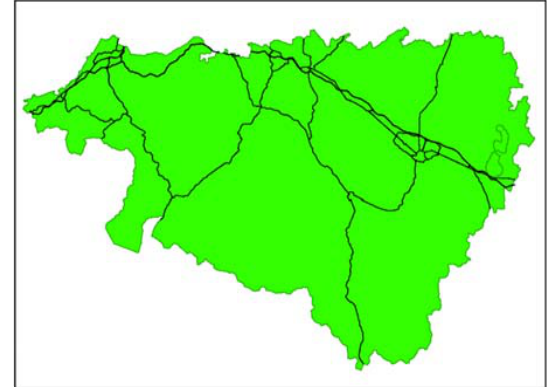
Figure 9: Primary road network of Pyrénées-Atlantiques (From Girres, 2012, p. 119). Source: IGN-BDTOPO.